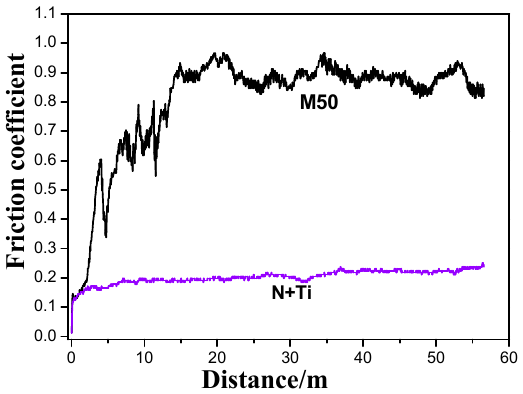
Figure 2. Comparison of the friction coefficient curves before and after N + + Ti + ion implantation for M50 steel.